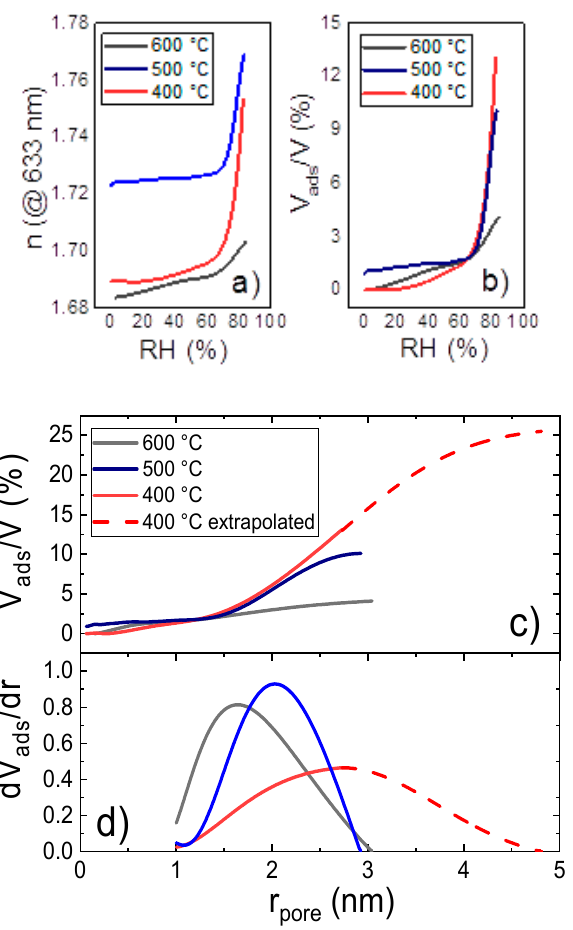
Figure 12. ( a ) Measured refractive index and ( b ) calculated volume fraction of pores filled with condensed adsorbate as a function of the relative humidity. ( c ) Volume fraction of pores filled with condensed adsorbate and ( d ) normalized PSD for pore radii > 1 nm as a function of the pore radius.